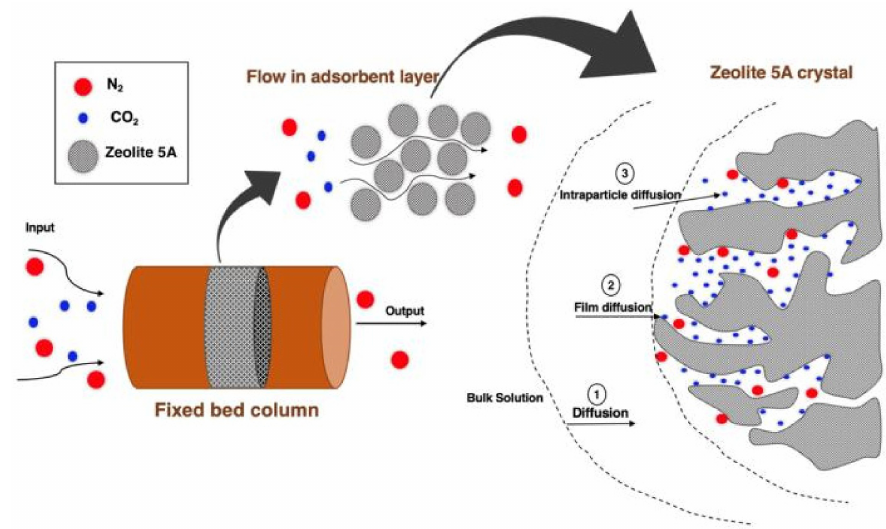
Figure 9. Adsorption mechanisms of CO 2 adsorption from CO 2 /N 2 gas mixture on zeolite